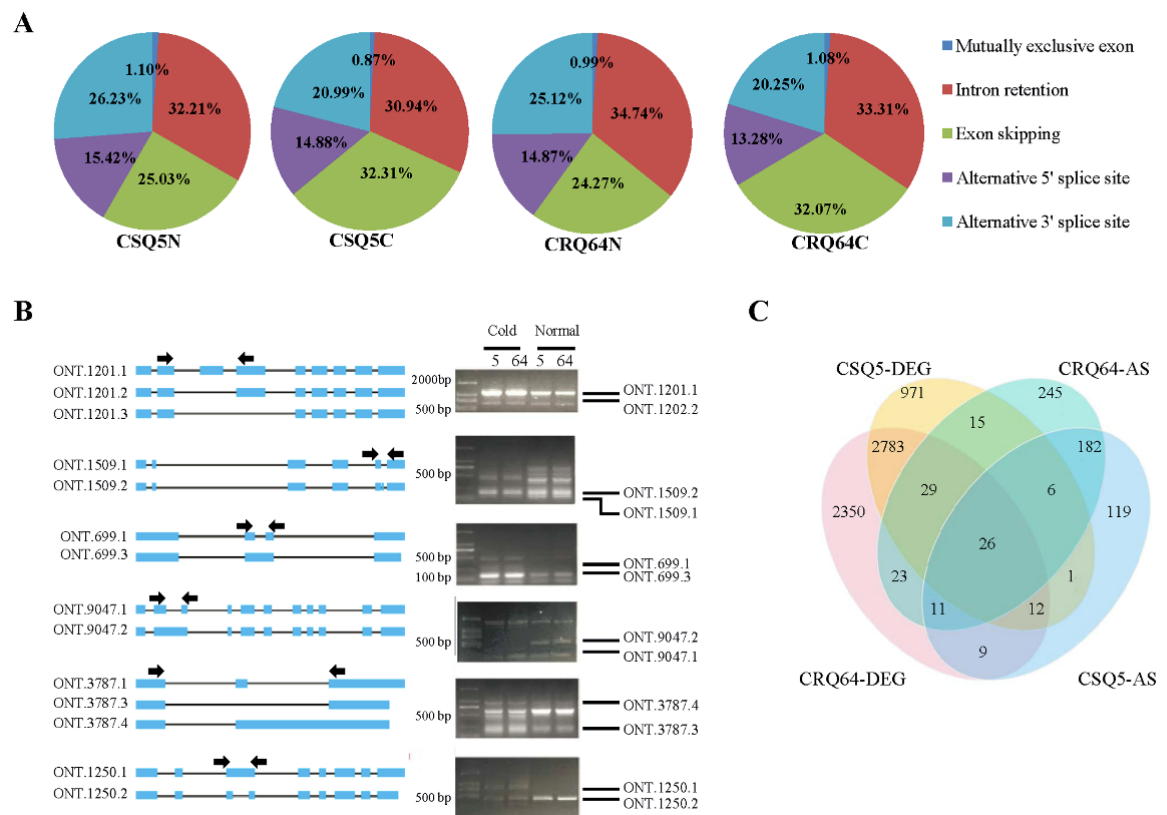
Figure 4. Distribution of alternative splicing in CSQ5 and CRQ64. ( A ) Distribution of types of alternative splicing in the different conditions. ( B ) RT-PCR verification of the AS events in CSQ5 and CRQ64. We selected four known genes AUR62040272 (ONT.1201), AUR62040994 (ONT.1509), AUR62042368 (ONT.699), and AUR62032383 (ONT.9047), and two novel genes, ONT.3783 and ONT.1250. Arrows indicate the positions of primers on selected genes. ( C ) Venn diagram of DEGs and genes with differential alternative splicing (DAS).